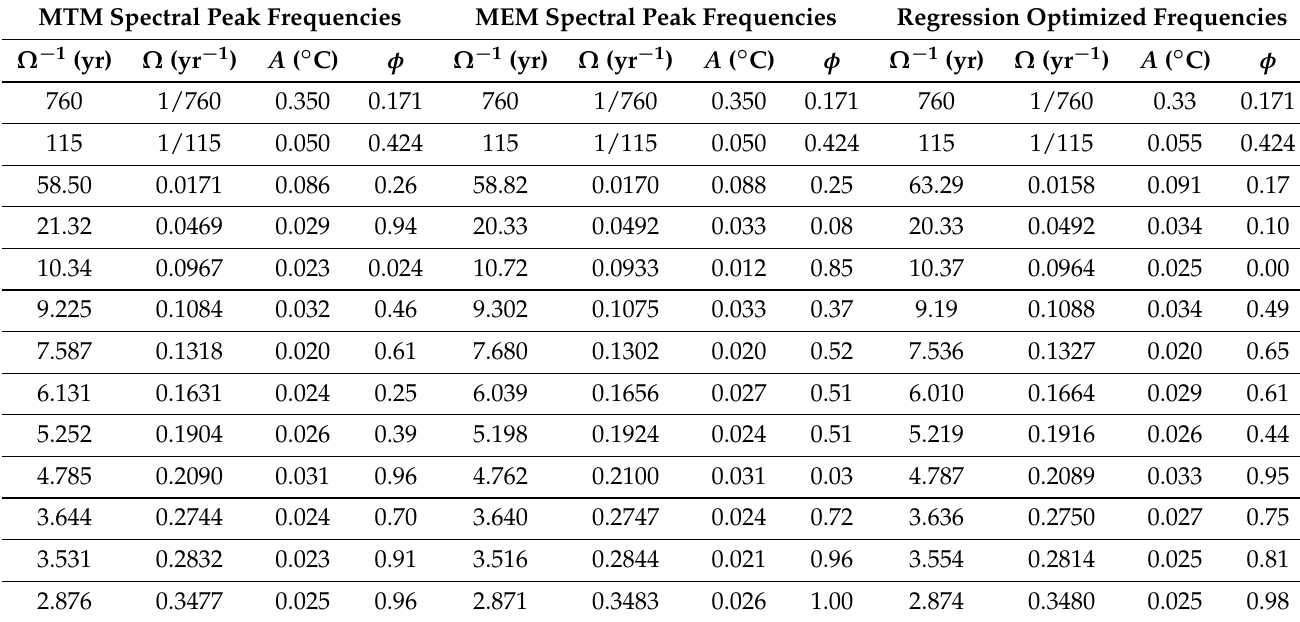
Table 2. Regression coefficient of Equation (1) using the temperature MTM and MEM spectral peaks with a 99% confidence level depicted in Figure 8C and after a non-linear regression optimization of the frequencies. The three sets of frequencies are compatible within the spectral resolution of the analysis. Ω − 1 is the period, Ω is the frequency, A is the amplitude of the sine wave and φ is the phase. The rmsr is 0.06–0.07 ◦